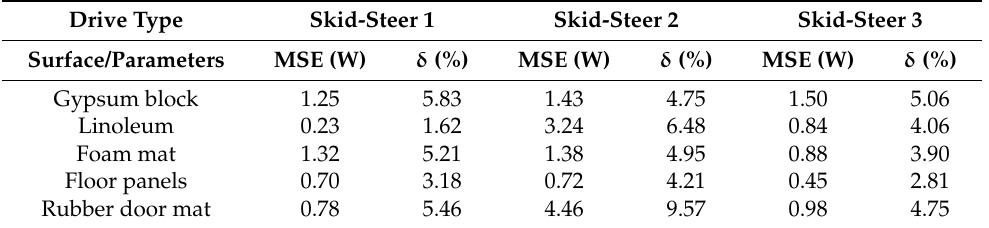
Table 10. The calculated values of quality factors for neural network of skid-steer drive robots. Drive